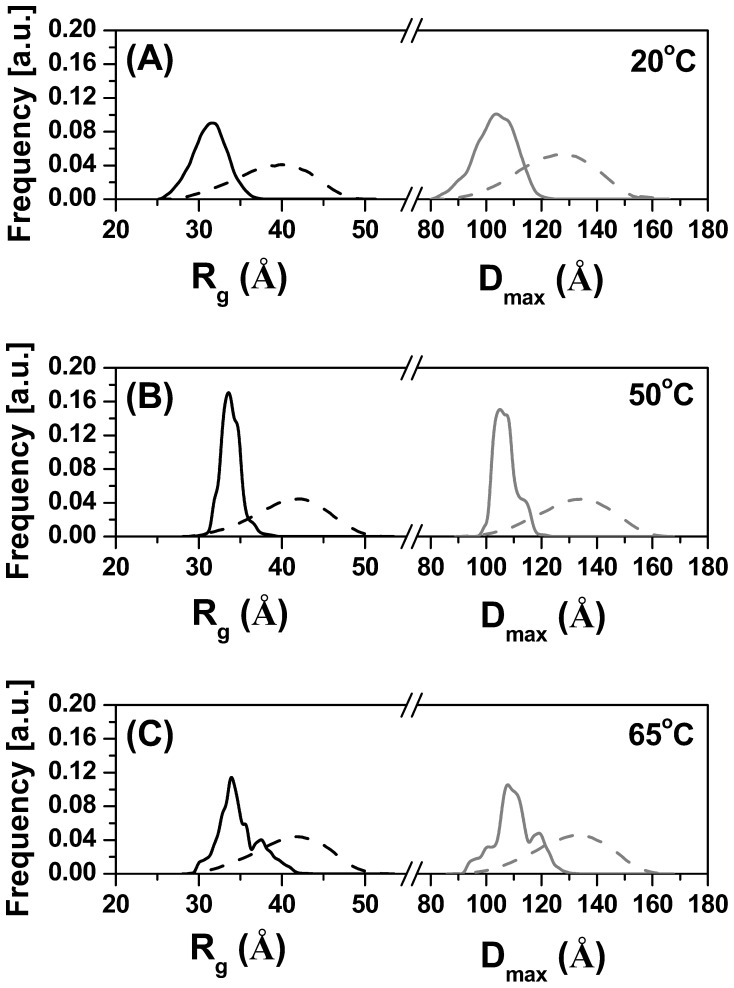
EOM modeling.(A) The dash lines are the distributions (Rg and Dmax) produced by the software from the SAXS data collected at 20°C, whereas the solid lines are the final distributions of structural parameters from the models selected by the ensemble optimization method [24]. (B) The dash lines are the distributions (Rg and Dmax) produced by the software from the SAXS data collected at 50°C, whereas the solid lines are the final distributions of structural parameters from the models selected by the EOM [24]. (C) The dash lines are the distributions (Rg and Dmax) produced by the software from the SAXS data collected at 65°C, whereas the solid lines are the final distributions of structural parameters from the models selected by the EOM.